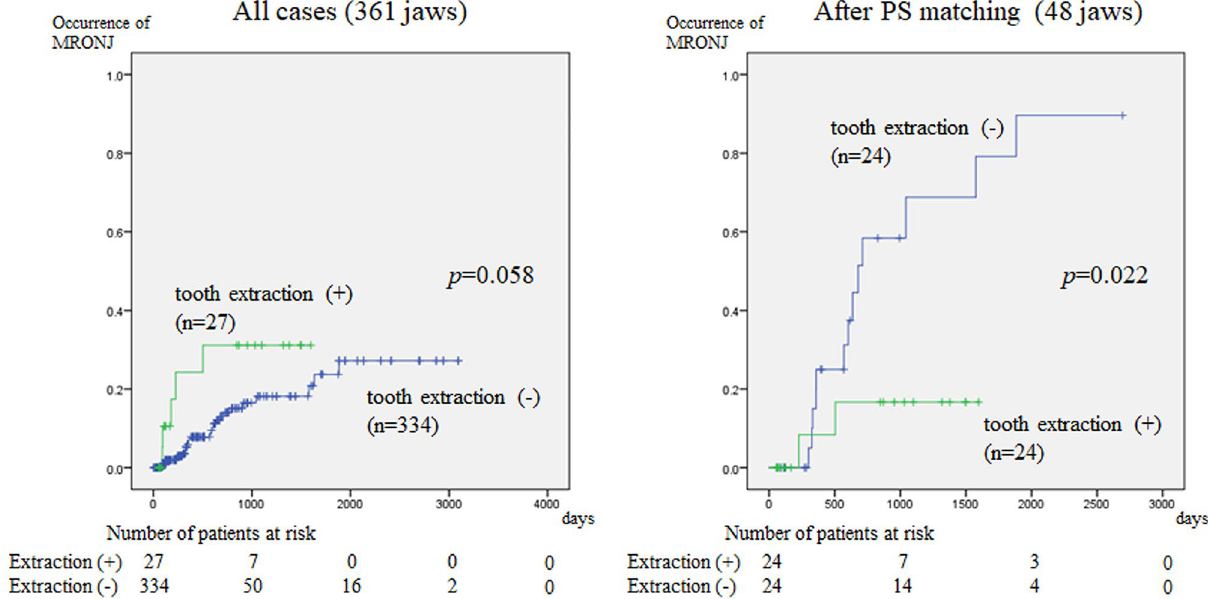
Figure 2. Relationship between tooth extraction and development of MRONJ. ( A ): Overall, MRONJ occurs earlier when tooth extraction is performed, although there is no significant difference in MRONJ incidence between the extraction and no-extraction groups. ( B ). After propensity score matching, the incidence of MRONJ is higher in the no-extraction group, indicating that tooth extraction significantly lowers the risk of